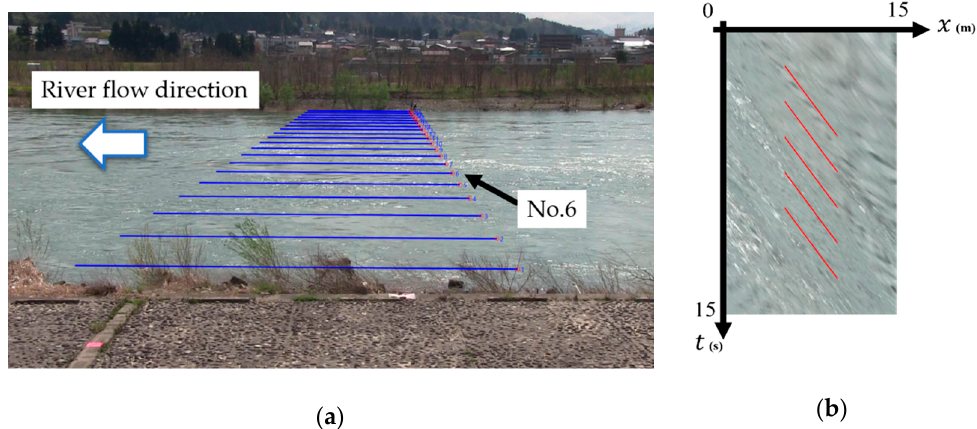
Figure 13. Wavy case: The boil vortices are actively interacting with the water surface. The combination of the dispersive waves caused by the boil vortices and the advection of the water surface features produces a complex pattern on the STI. ( a ) Obliquely viewed image; ( b ) STI, No.6 (red lines are CNN estimated angles).